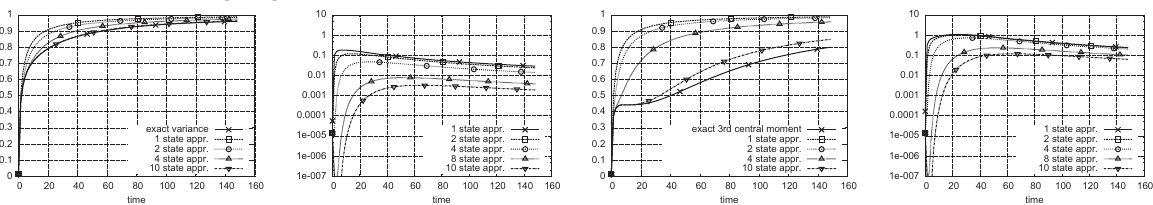
Figure 4: Variance (first plot), relative error of variance (second), third central moment (third) and relative error of the third central moment (fourth) with λ = 1 ,μ = 5 and with initially ten client in the system. The peaks in the last plot are due to the fact that the third central moment changes sign twice.